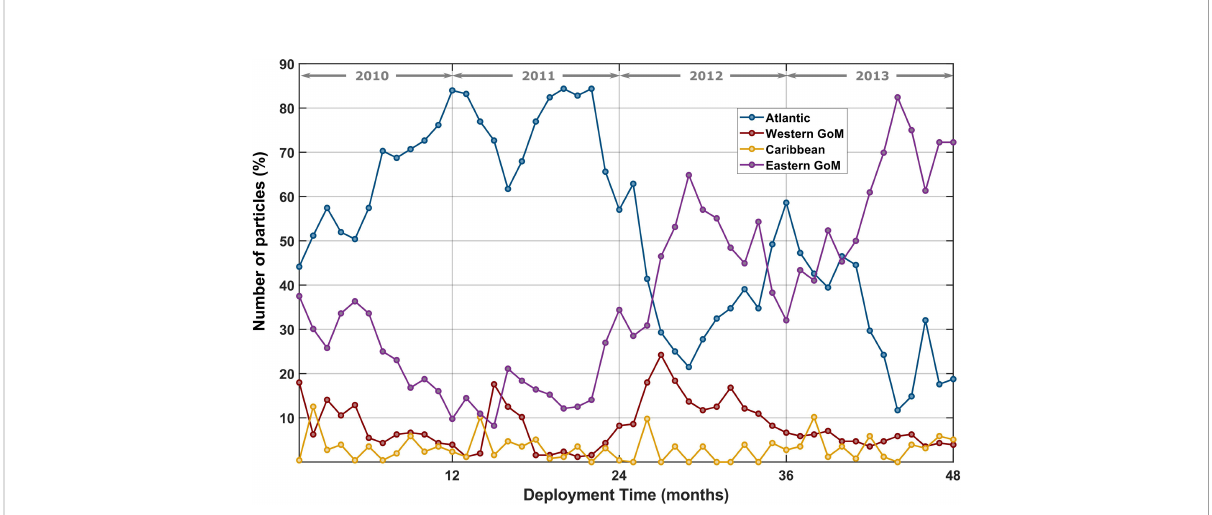
FIGURE 12 ROMS virtual particles ’ fi nal destination as a function of deployment month, divided into the Atlantic (blue line), western GoM (red line), Caribbean (yellow line), and eastern GoM (purple line). Regions are de fi ned as follows: Atlantic is east of 82°W, western GoM is west of 92°W, the Caribbean is south of 22°N, and eastern GoM is within the bounds of 22°N – 30°N and 82°W – 92°W (see Figure 1). Once a virtual particle exits the eastern GoM into one of the three locations, that location is considered its fi nal destination. If after a virtual particle ’ s 1-year drift it has not exited into one of the three locations, the eastern GoM is considered its fi nal destination.